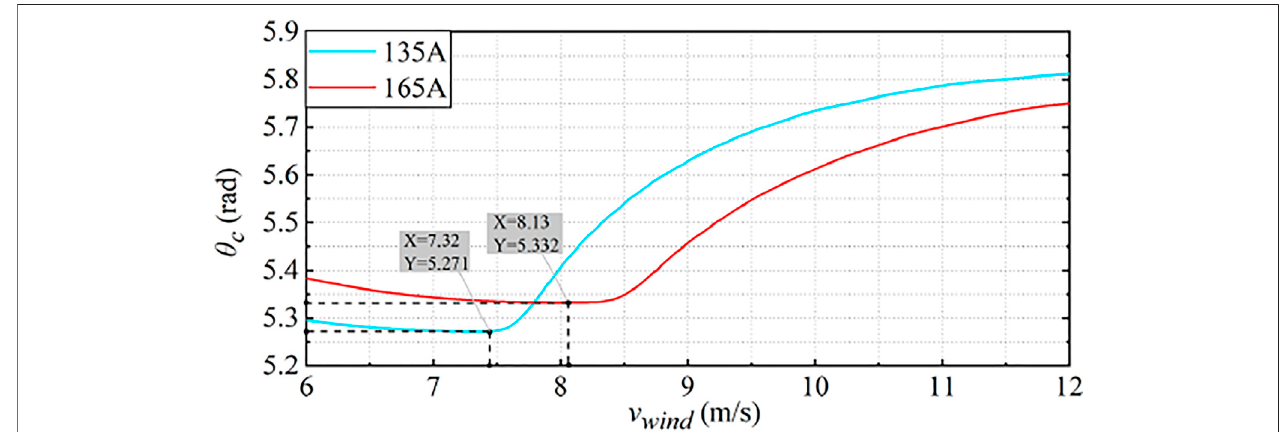
FIGURE 9 | Optimal circulating current phase angle under different wind speeds.